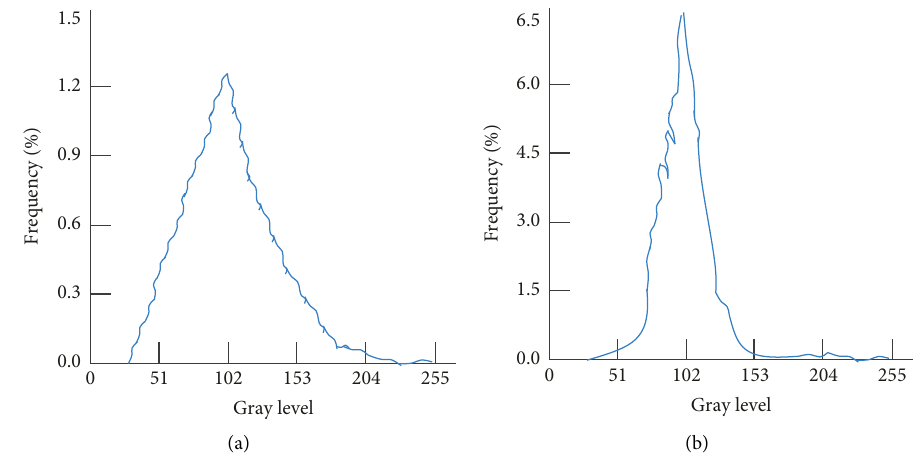
Figure 5: Pixelgray distribution histogram. (a) SEM image and (b) FIB/SEM image.